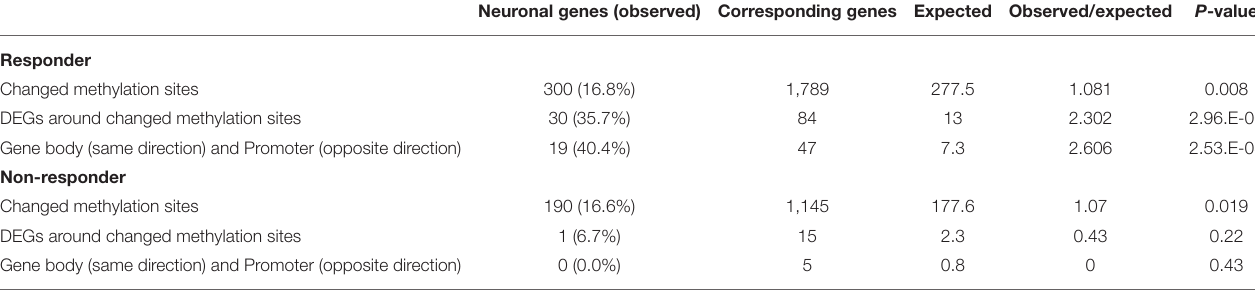
TABLE 3 | The proportion of genes associated with neuronal and synaptic functions. Neuronal genes (observed) Corresponding genes Expected Observed/expected P